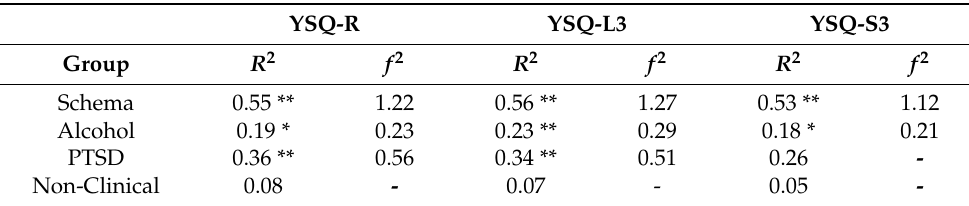
Table 3. Regression Analysis of Total Pre-Treatment EMS in each YSQ Version and Pre-Treatment Total Symptom Scores Across Each